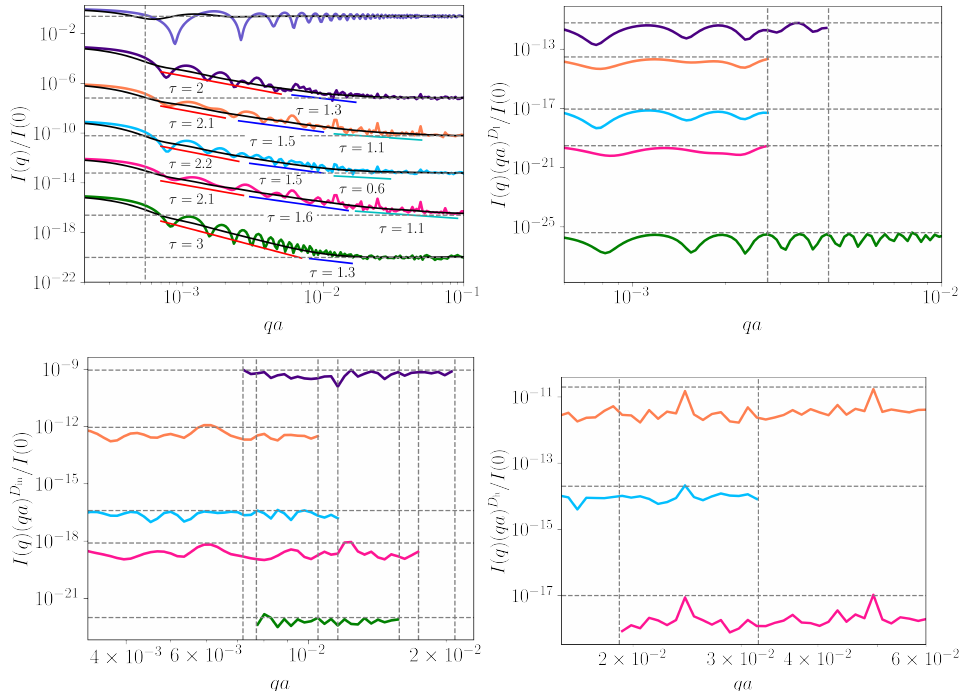
Figure 9. ( Upper left ) SAS intensities (Equation (5)) from periodic “ATGC” sequence (violet), random sequence (green), E. coli (dark violet), M. mitochondrion (orange), H. sapiens mitochondrion (light blue) and H. cosmid (pink) at k = 13. Black lines: polydisperse SAS intensities (Equation (7)). Horizontal dashed lines: the asymptotic values. Vertical dashed lines: end of Guinier region and beginning of the power-law decay (see text for details). τ represents the scattering exponent. a is a measure of the “ATGC” square. All curves, except the periodic one, are shifted vertically down for better visualization. ( Upper right , lower left , lower right ) the functions I ( q )( qa ) τ vs. q on the first, second and third power-law decays with τ = D l , τ = D in and τ = D h , respectively, used to emphasize the periodicity of SAS intensities. Here, D l is a surface fractal dimension, while D in and D h are mass fractal dimensions (see text for details). Vertical dashed lines represent the end of the fractal region for each